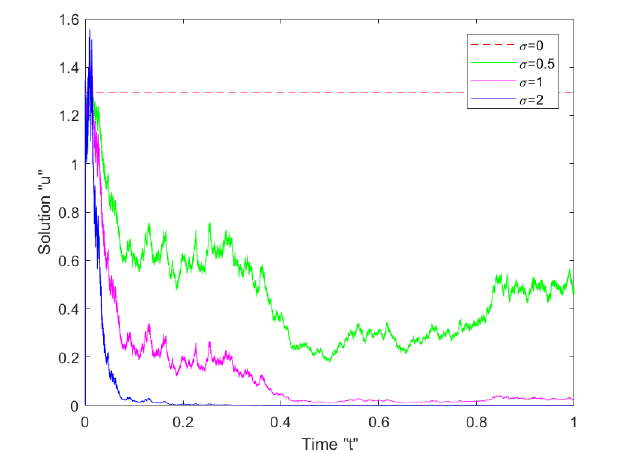
Figure 3. Two-dimensional (2D) plots of the solution (48) with α =